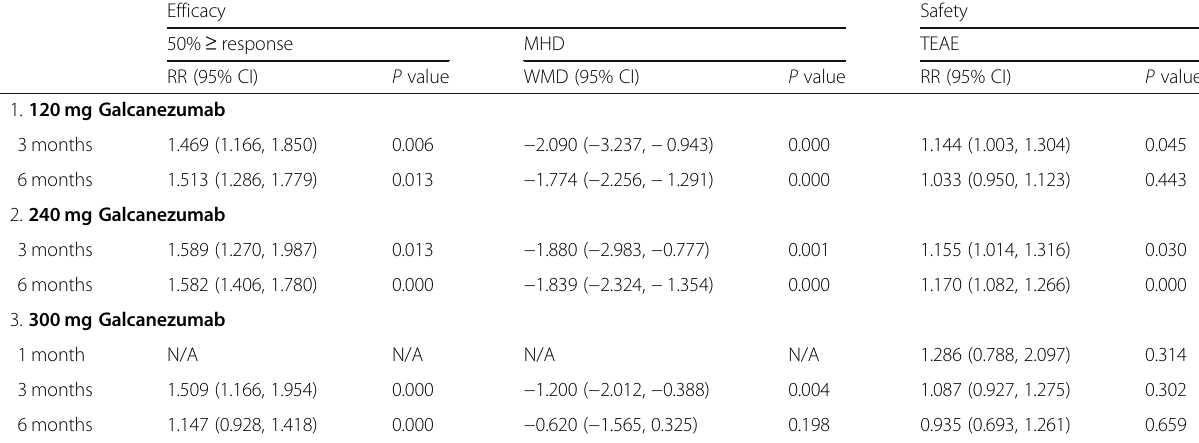
Table 2 Subgroup analysis of efficacy and safety outcome of galcanezumab for the treatment of migraine Efficacy Safety